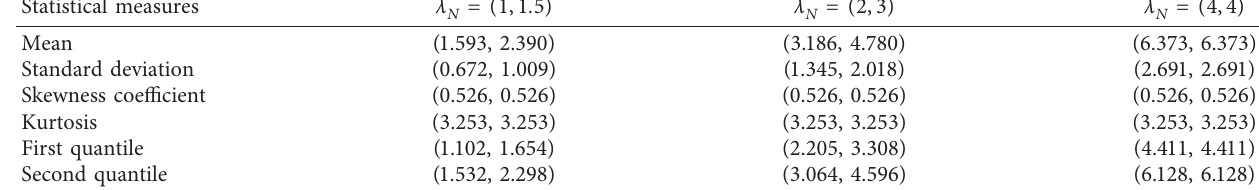
Table 2: Descriptive measures and quantile points of NMD for simulated data.